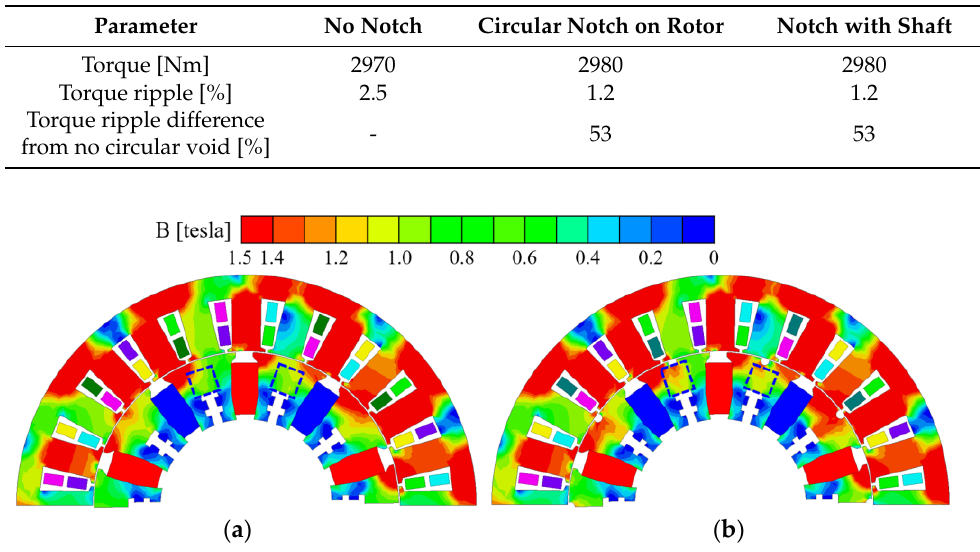
Figure 11. Flux density distribution of 6Φ -SS-FSCW-Fer-SIPMSM with ( a ) shaft only and ( b ) shaft and circular notch on the rotor.